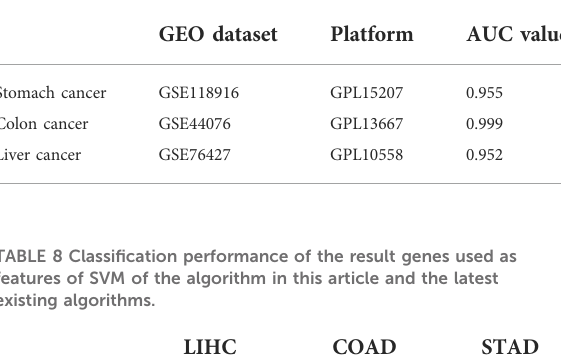
TABLE 7 Class fi ciation performance of fi nal leader genes for GEO datasets.